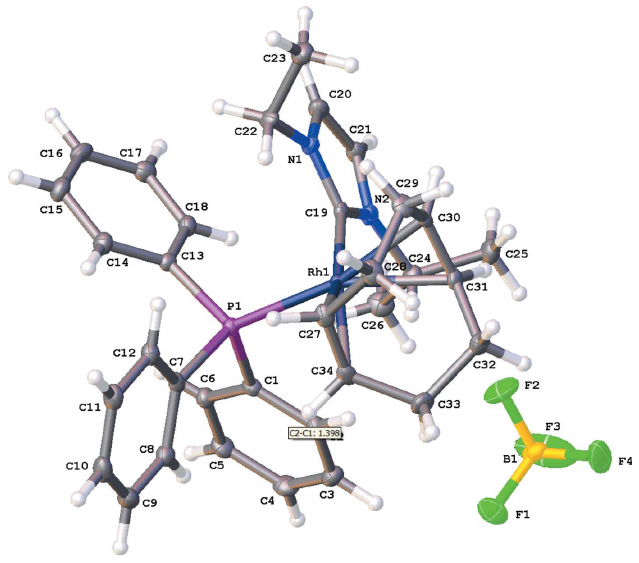
Figure 3 Reaction scheme summarizing the synthesis of the N -heterocylic carbene ligand through the formation of the title salt ( 4 ).